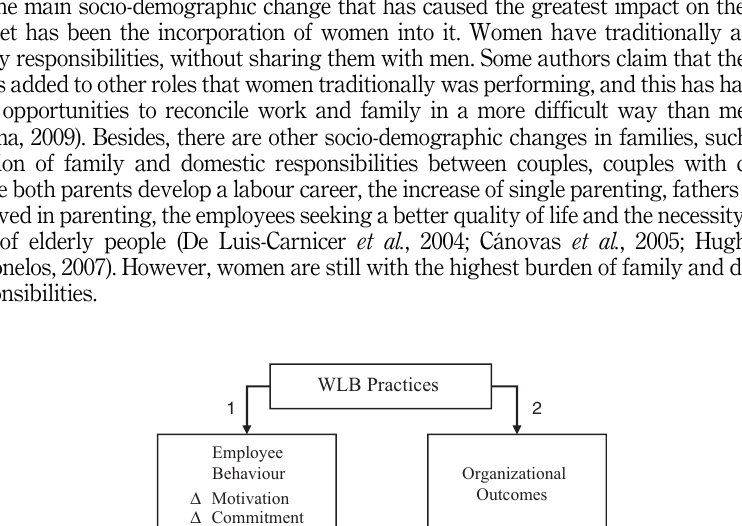
Figure 1. Two lines of